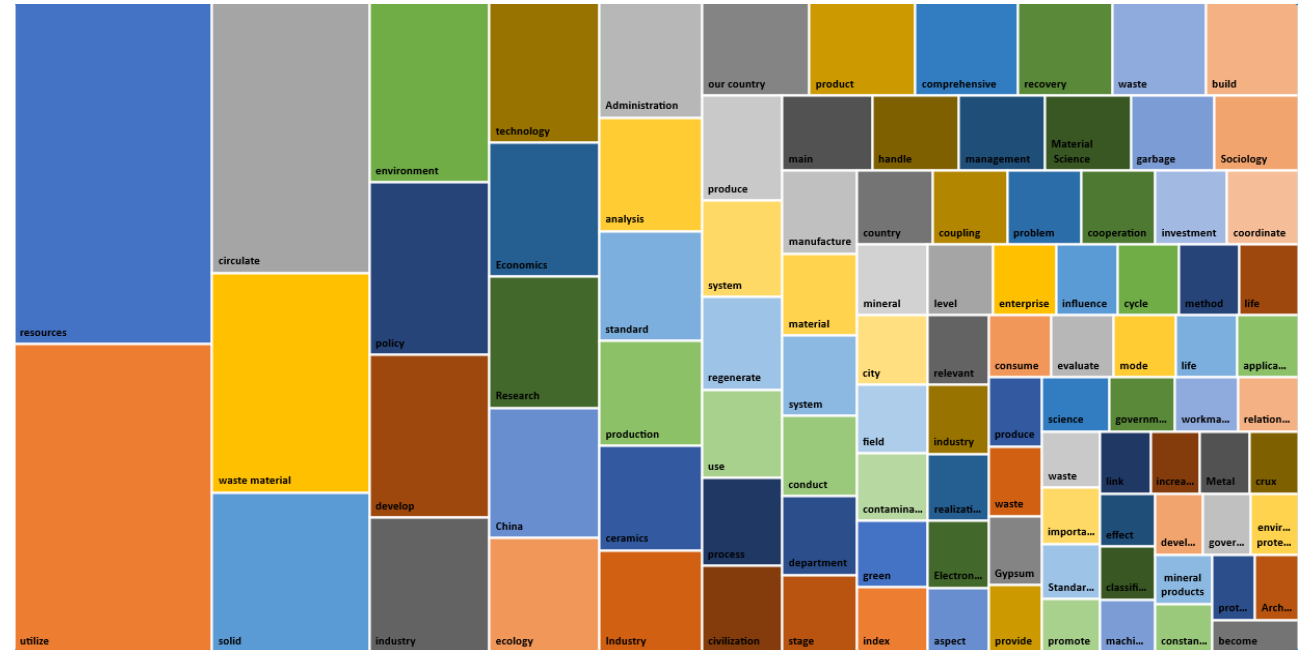
Figure 2. Tree structure of high word-frequency moment form .